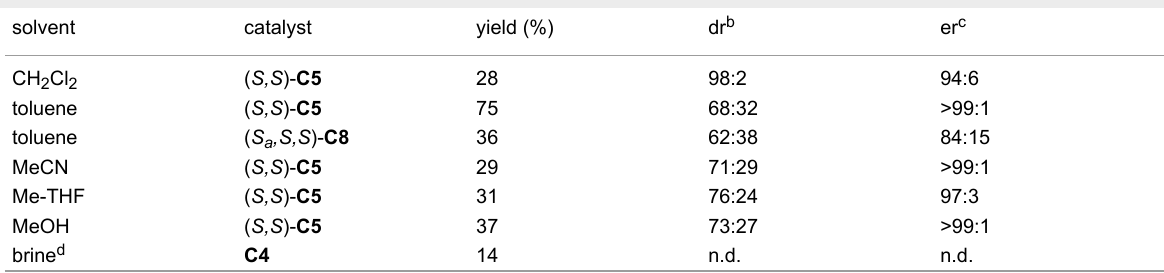
Table 2: Solvent screening in the addition of dimethyl malonate to nitroalkene 6 . a